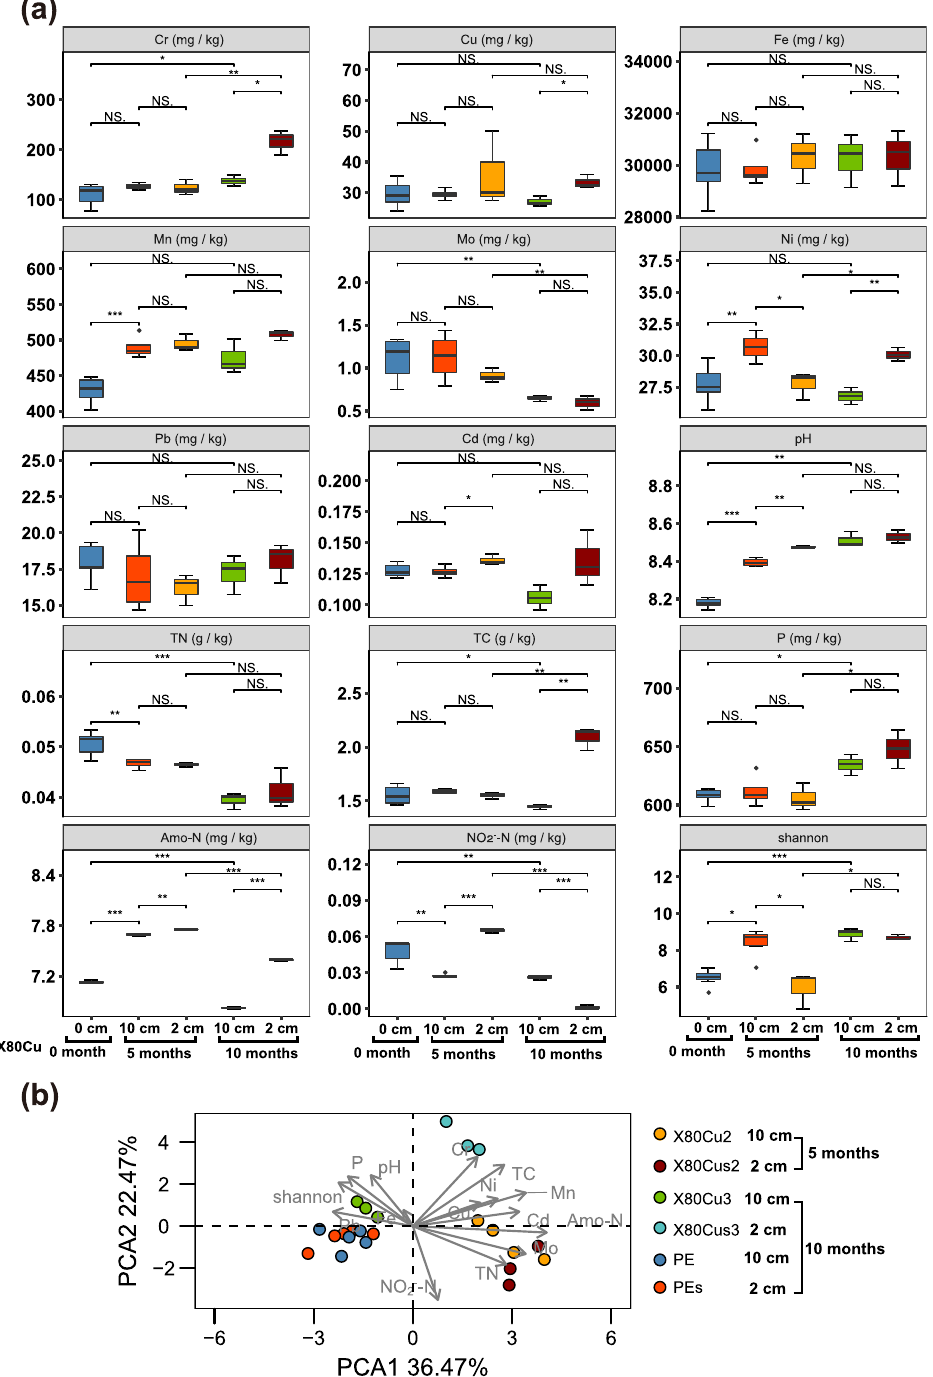
Fig. 3 Physicochemical properties of the soil for X80Cu groups. Differences in physicochemical properties of the soil at different time points and different distances (from left to right, n = 7, 4, 3, 3, and 3) for X80Cu coupons ( a ) and principal component analysis (PCA) of soil parameters for X80Cu and PE ( b ). Note: error bars represented SD; * p -value < 0.05; NS, means p -value > 2 and 10 cm from the metal surface buried for 5 months (Supplementary Fig. 4). However, after 10 months, the difference between the microbial community structures in soil at 2 and 10 cm from the metal surface was no longer signi fi cant (for Q235, ADONIS, F = 1.17, p = 0.32, and for X80Cu, ADONIS, F = 0.94, p = 0.32) (Supplementary Table 6).